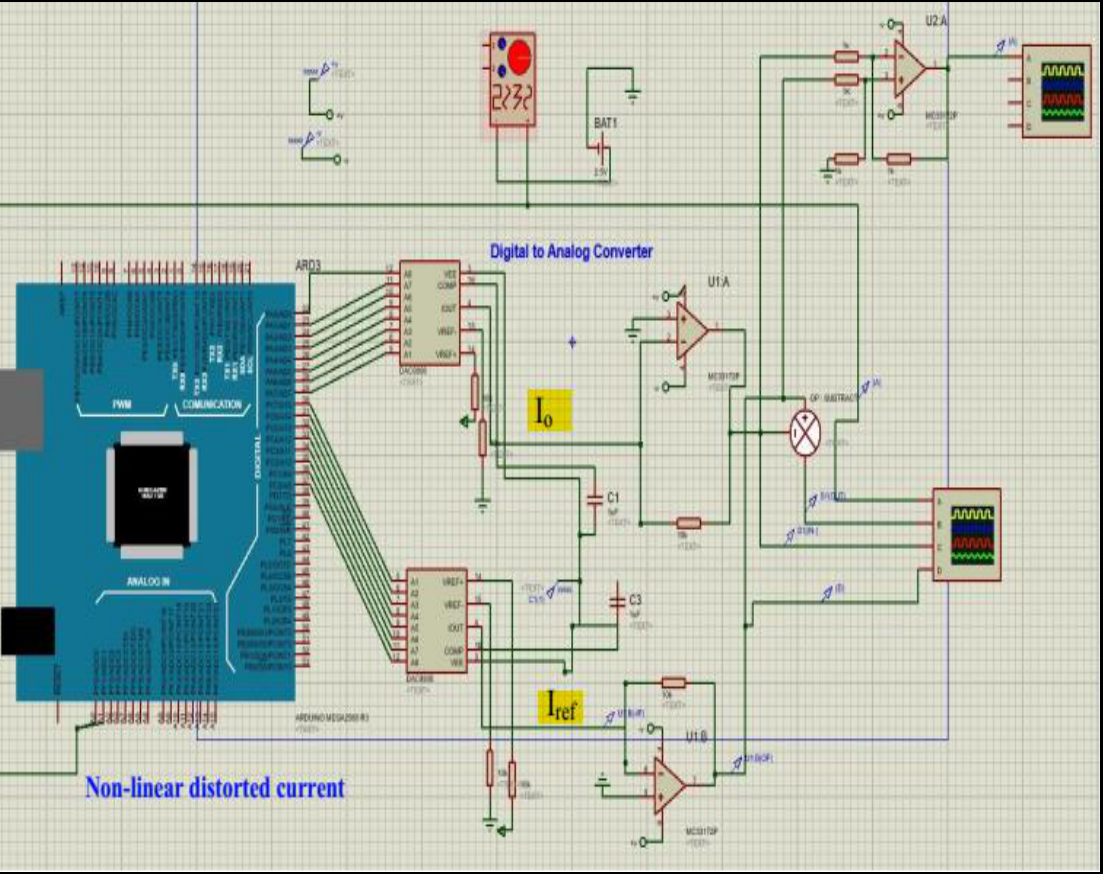
Figure 7. Simulation scheme of digital notch filter signals using Proteus VMS.